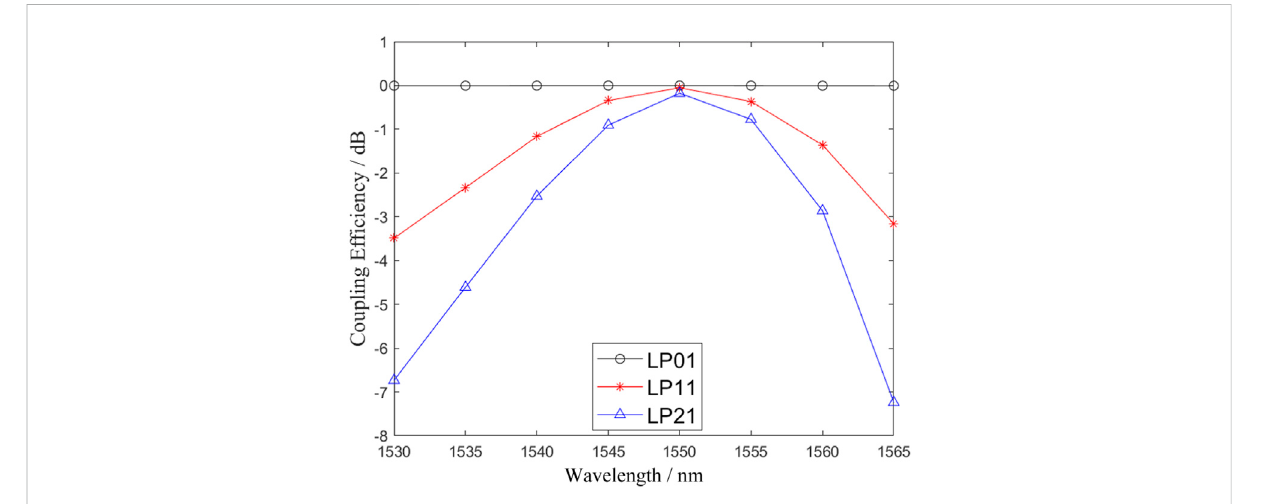
FIGURE 9 Coupling ef fi ciency of each mode of our proposed MUX/DEMUX in the